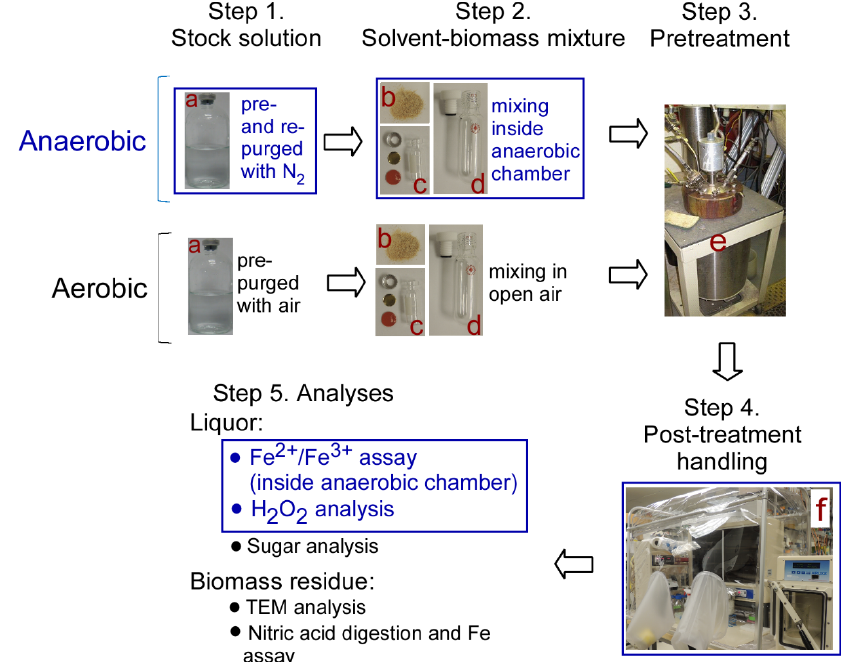
Figure 4. Flow-chart of the main steps and apparatus in anaerobic versus aerobic pretreatments, subsequent handling and analytic processes. Blue outlines indicate the related experiments conducted with N 2 purging or inside an anaerobic chamber. Materials and apparatus used: a : 250-mL serum bottle; b : corn stover; c : 2-mL glass vials with copper disc and septum/aluminum cap for regular scale pretreatment; d : 65-mL pressure tubes for scale-up pretreatment; e : Parr reactor; f : Anaerobic chamber. Abbreviations: HPLC, high-performance liquid chromatography; TEM, transmission electron microscopy.